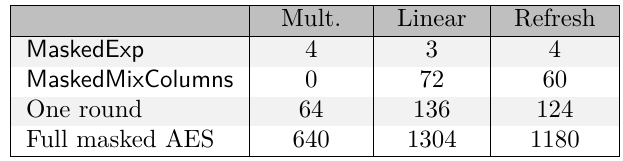
Table 4: Gadget counts for masked